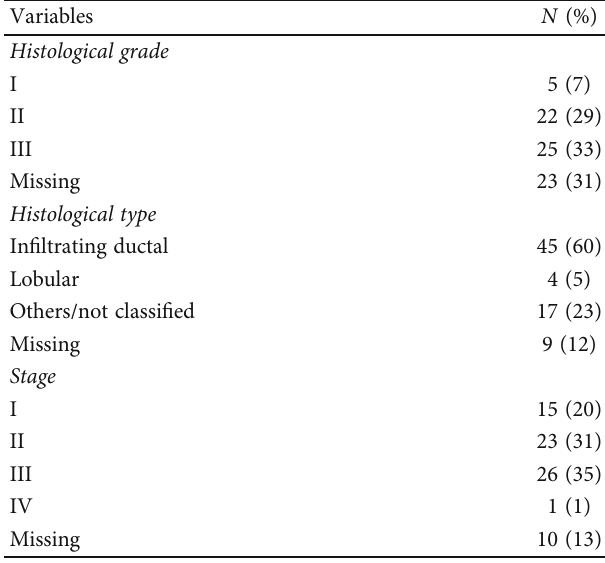
Table 1: Baseline pathological characteristics of the study participants ( n = 75 ).